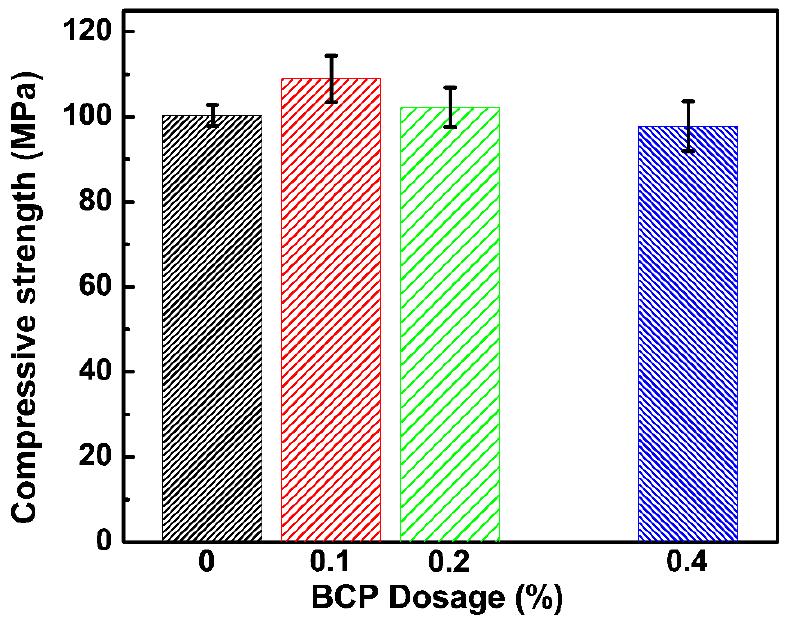
Figure 5. 28-day compressive strength of 0.1, 0.2, and 0.4 wt% PS- b -PAA micelle doped cement paste samples. The control one is also presented for comparison.